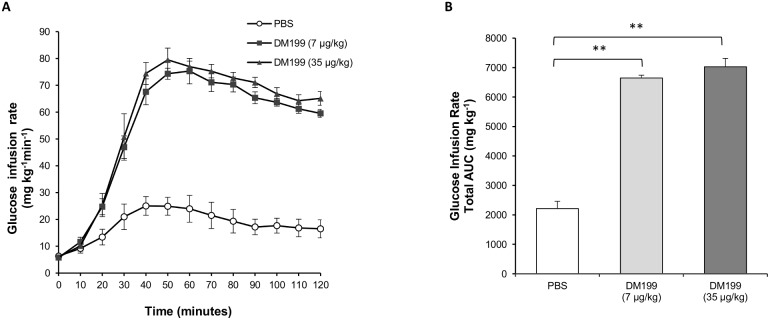
The effect of DM199 on glucose infusion rate during a hyperinsulinemic-euglycemic clamp.Catheterized Sprague-Dawley rats (n = 4; age 11–12 weeks) were injected s.c. with either PBS (Control), or DM199 (7 and 35 µg/kg) 30 minutes prior to commencement of a 120-minute hyperinsulinemic-euglycemic clamp (HEC). (A) Profile of glucose infusion rates during HEC. (B) Glucose infusion rate total AUC. Data are presented as the mean ± SEM, **p<0.01 vs. control.